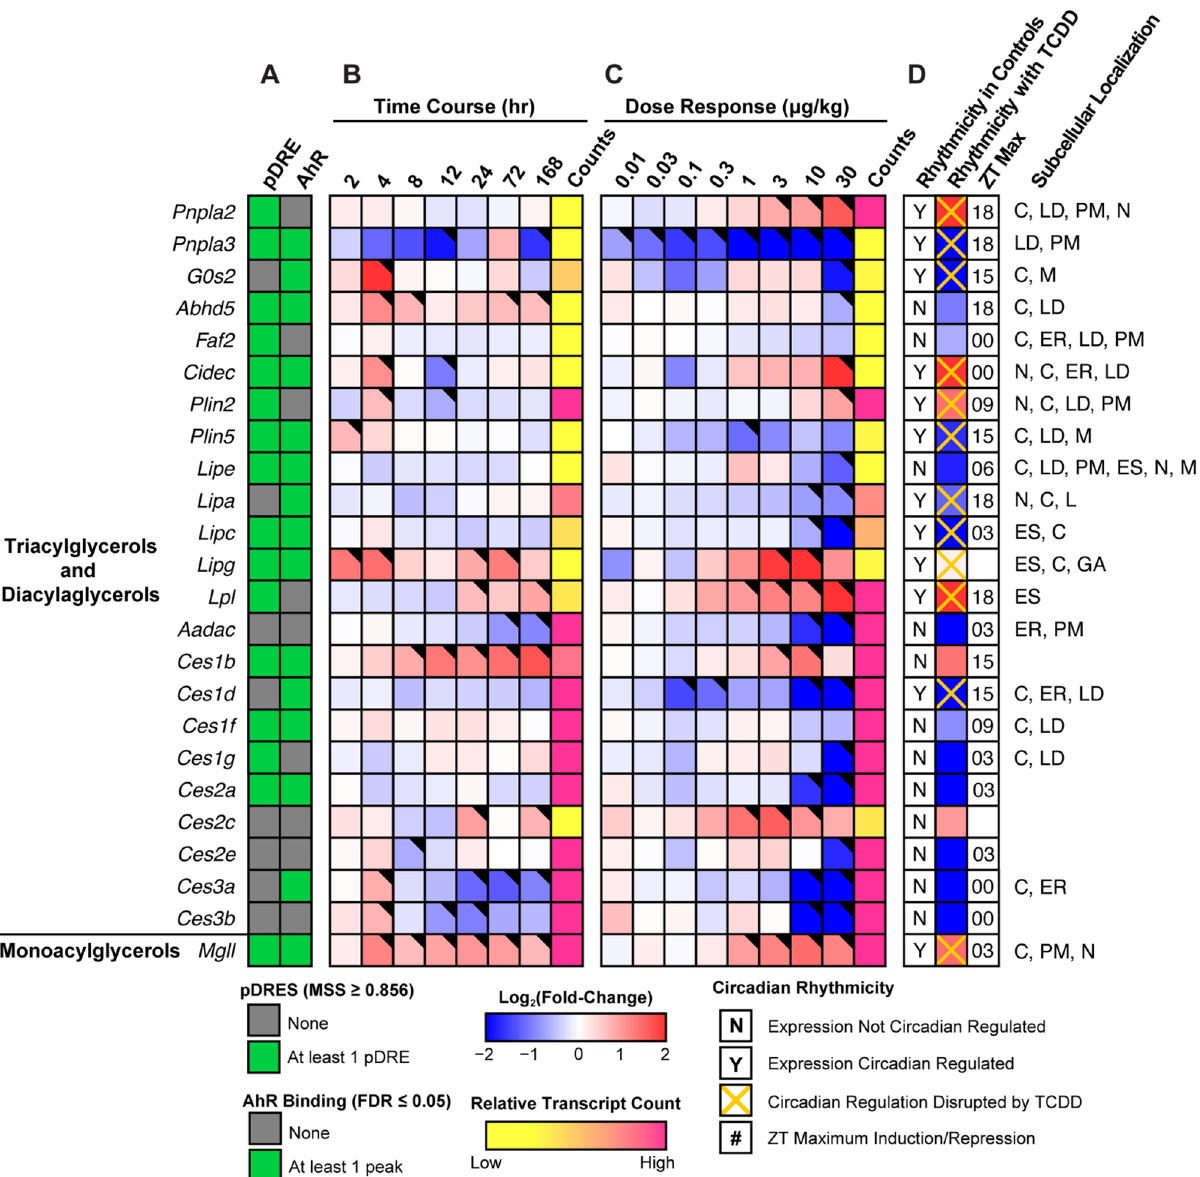
Figure 1. Effect of TCDD on lipid hydrolysis gene expression. Differential expression of genes associated with triacylglycerol hydrolysis assessed using RNA-seq. Mouse Genome Informatics (MGI) official gene symbols are used. ( A ) The presence of putative dioxin response elements (pDREs) and AHR genomic binding at 2 h. ( B ) Time-dependent expression following a single bolus dose of 30 μg/kg TCDD (n = 3). ( C ) Dose-dependent expression assessed following oral gavage every 4 days for 28 days with TCDD (n = 3). ( D ) Diurnal regulated gene expression denoted with a “Y”. An orange ‘X’ indicates abolished diurnal rhythm following oral gavage with 30 μg/kg TCDD every 4 days for 28 days. ZT indicates statistically significant (P1( t ) > 0.8) time of maximum induction/repression. Counts represents the maximum number of raw aligned reads for any treatment group. Low counts (< 500 reads) are denoted in yellow with high counts (> 10,000) in pink. Differential gene expression with a posterior probability (P1( t )) > 0.80 is indicated by a black triangle in the top right tile corner. Protein subcellular locations were obtained from COMPARTMENTS and abbreviated as: cytosol (C), endoplasmic reticulum (ER), extracellular space (ES), Golgi apparatus (GA), lipid droplet (LD), lysosome (L), mitochondrion (M), nucleus (N), and plasma membrane (PM). The heatmap was created using R